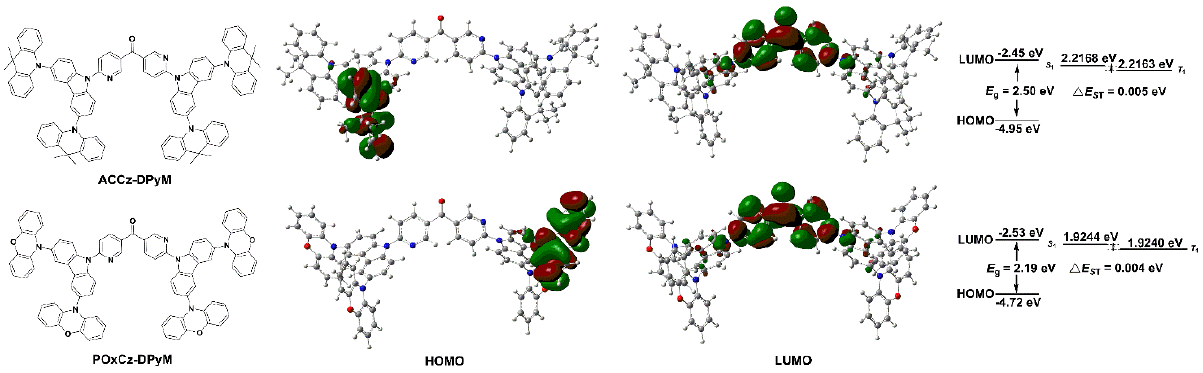
Figure 1. Optimized molecular orbital based on B3LYP/6−31G*, HOMO and LUMO energy levels for two compounds. for two